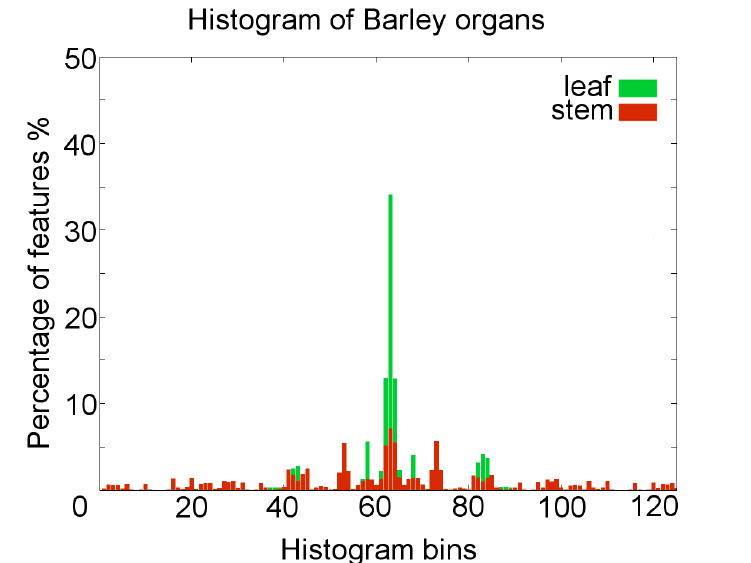
Figure 3. Surface feature histogram representations were calculated for every point in the point cloud. The mean 125-bin histogram is shown for points from the leaf point cloud and the stem point